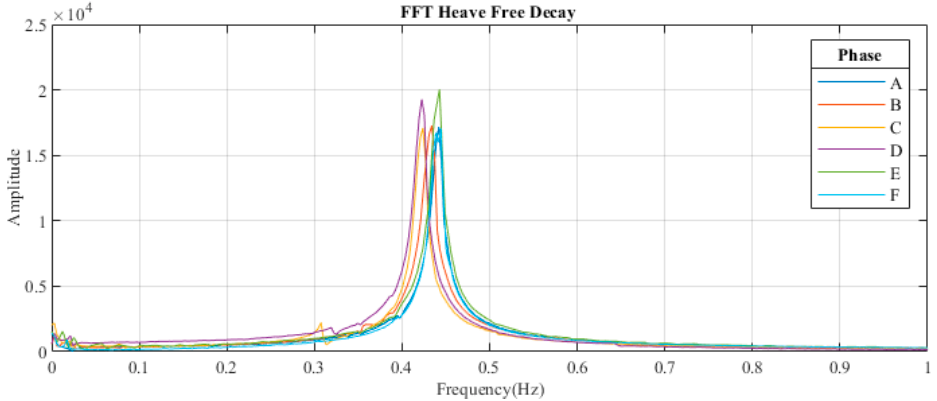
Figure 7. Fast Fourier transform (FFT) of free decay of heave motion for all phases of testing. Table 4. Estimated natural frequency of heave, surge, sway and pitch motions.